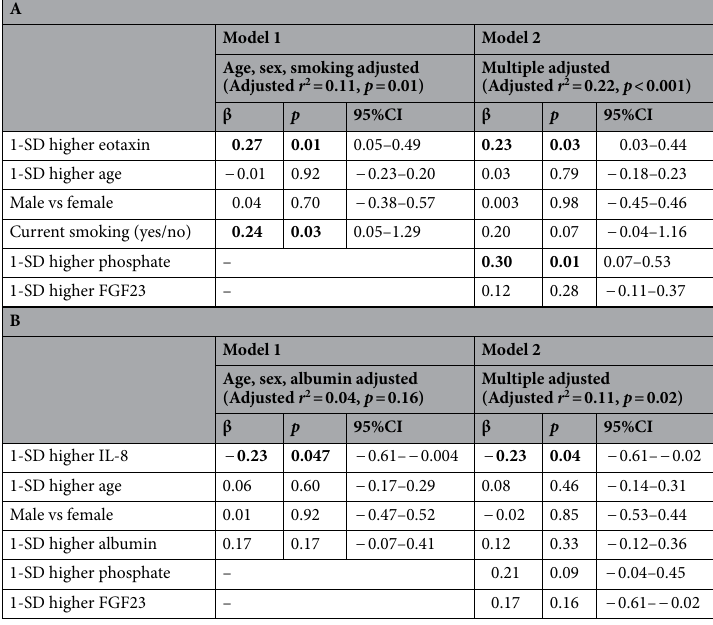
Table 3. Multiple regression models for 1-SD increase of H-CPP ( A ) and 1-SD increase of L-CPP ( B ) in 78 HD patients. Signigficant values are in bold. β standardized regression coefficient; 95%CI, 95% confidence interval for regression coefficient; SD standard